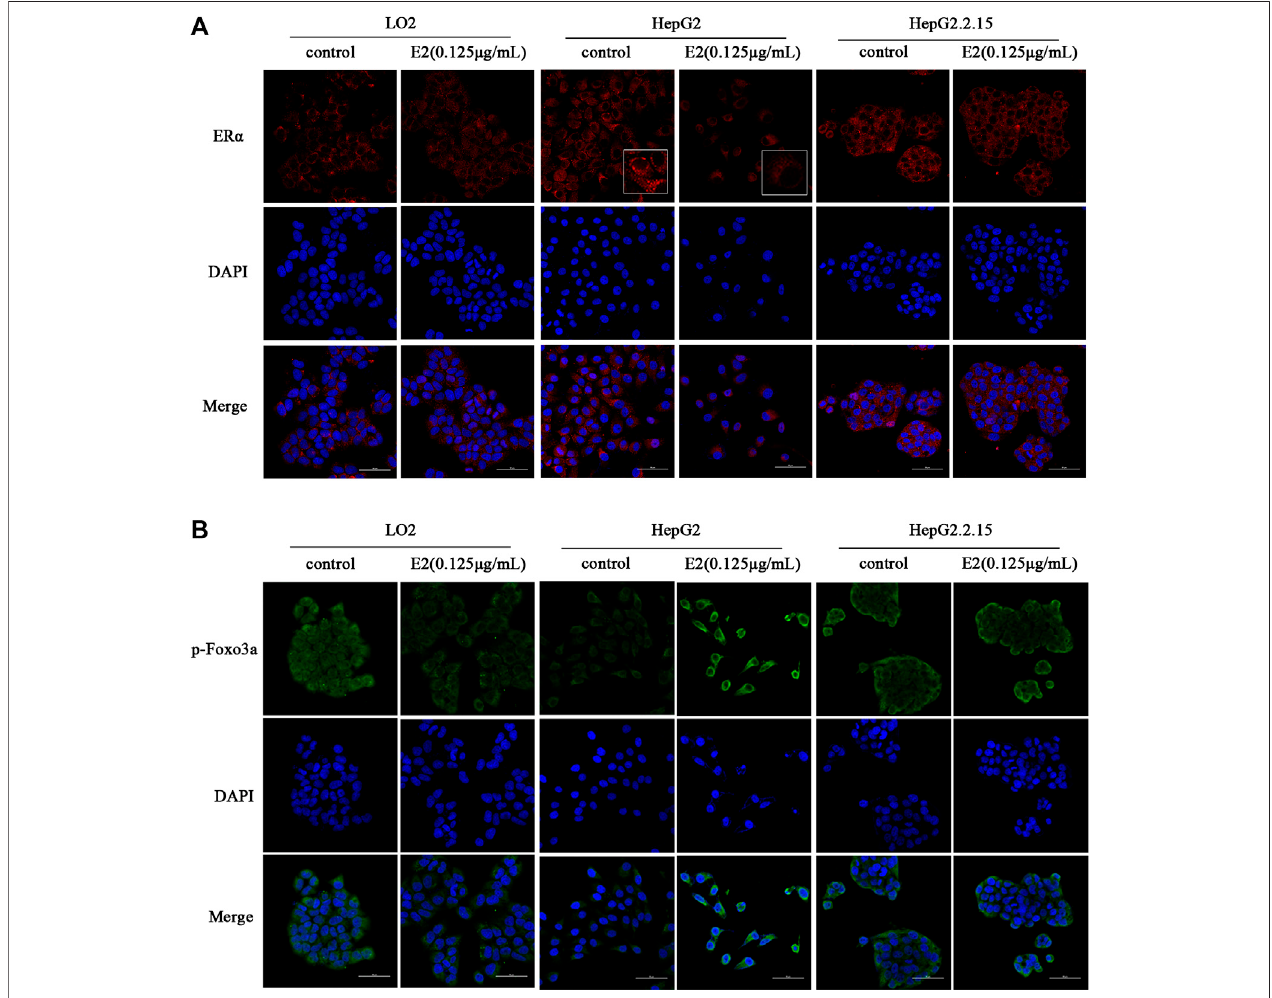
FIGURE 5 | The effects of 17 β -estradiol (0.125 μ g/ml for 48 h) on ER α (A) and p -Foxo3a (B) expression and localization. The effects on HepG2, HepG2.2.15, and LO2 cells, respectively, as revealed by fl uorescence microscopy.